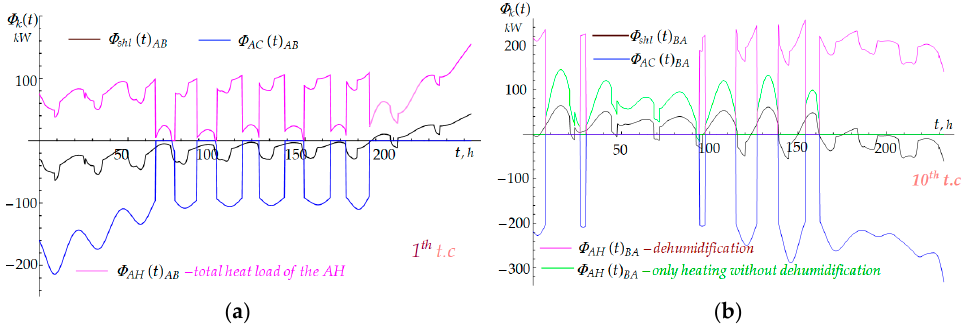
Figure 14. Characteristics of heat loads for ship’s accommodation during navigation: ( a ) from A to B through 1st transport cycle and ( b ) during navigation from B to A through 10th transport cycle.